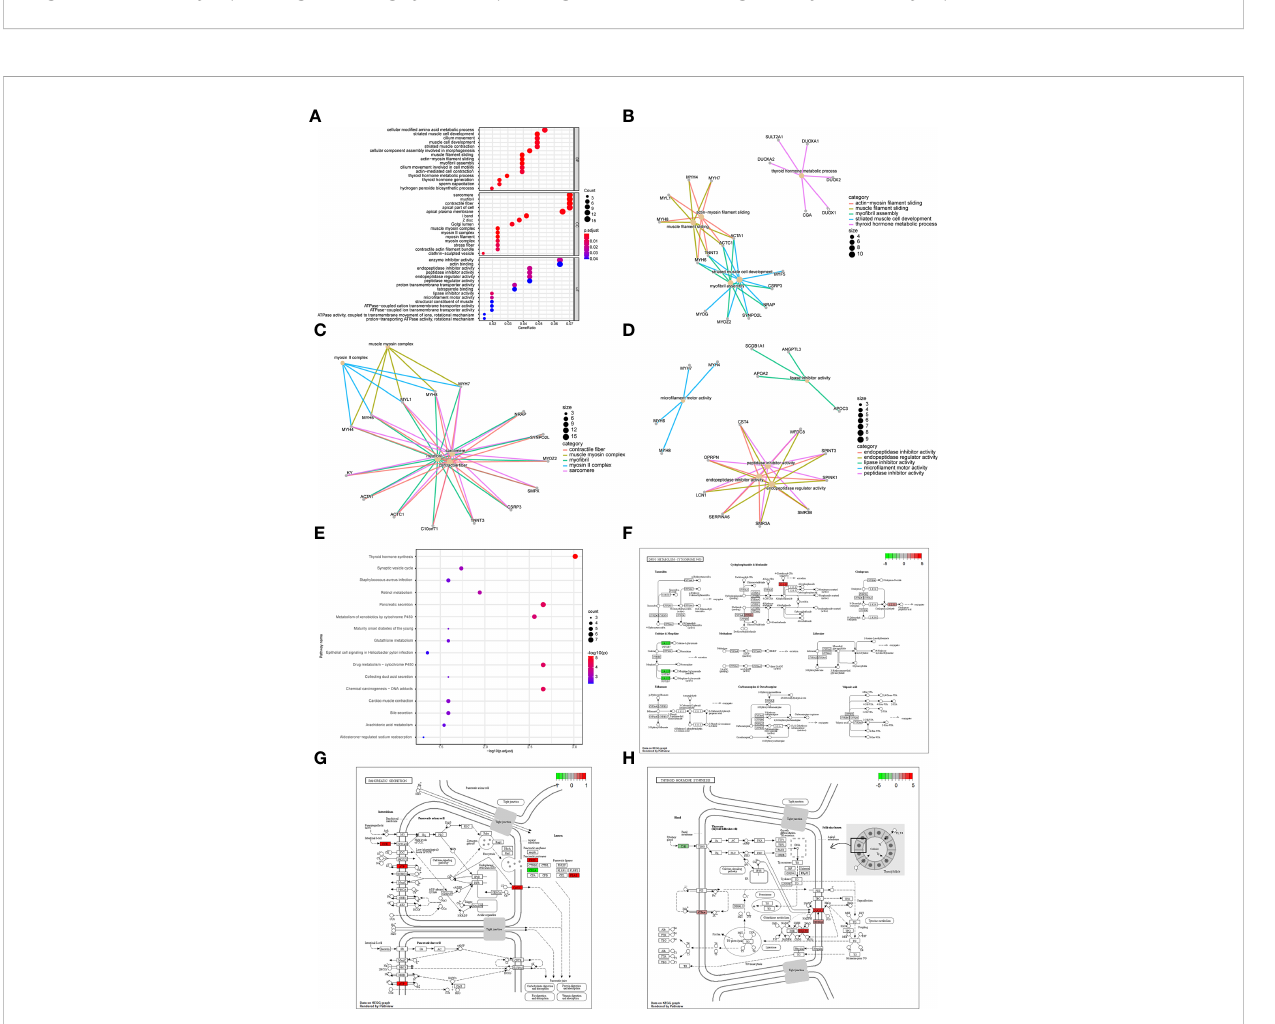
FIGURE 9 Enrichment analysis of differentially expressed genes between patients in a high-risk group and low-risk group. (A) GO functional enrichment analysis, the vertical axis is gene ratio, the horizontal axis is GO terms, the node color indicates -log10 (p value), and the node size indicates the number of genes contained in the current GO Term. (B) The fi rst 5 items of BP are listed, the node ’ s size indicates the number of genes contained in the current GO Term, and the different colors indicate different GO Term. (C) The fi rst 5 items of CC are listed, the node size indicates the number of genes contained in the current GO Term, and the different colors indicate different GO Term. (D) The fi rst 5 items of MF are listed, the node size indicates the number of genes contained in the current GO Term, and the different colors indicate different GO Term. (E) KEGG pathway enrichment analysis, the horizontal axis was -log10 (p value), the vertical axis is the Pathway name, the node size indicates the number of genes enriched in the pathway, and the node color indicated -log10 (p value). (F) KEGG pathway with signi fi cant enrichment. hsa00982: Drug metabolism - cytochrome P450. (G) KEGG pathway with signi fi cant enrichment, hsa04972: Pancreatic secretion. (H) KEGG pathway with signi fi cant enrichment, hsa04918: Thyroid hormone